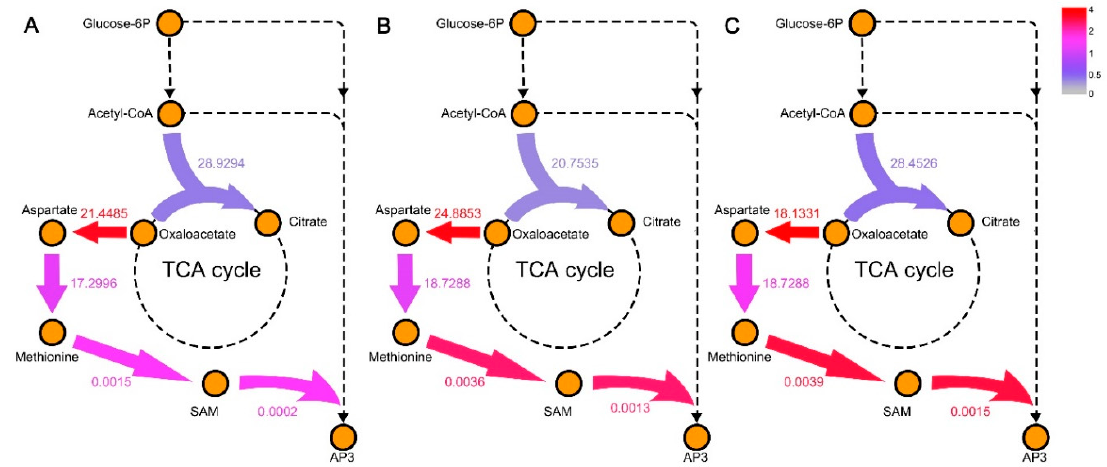
Figure 7. The flux change of methionine biosynthesis and tricarboxylic acid cycle (TCA cycle) in the specific models for day 2 ( A ), day 3 ( B ), and day 5 ( C ) compared with day 1. The values represent the flux through each reaction. The colored arrow represent the ratio of flux in each day to that of day 1. SAM: S-adenosyl-L-methionine.